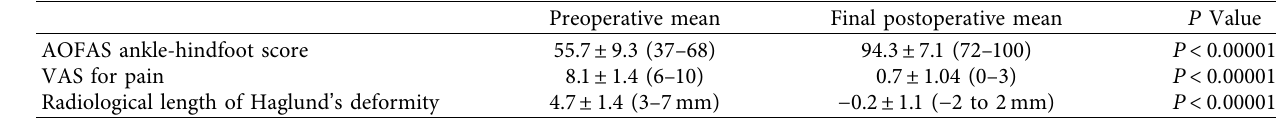
Figure 6: Adequate endoscopic resection of the bone with no prominence above the parallel pitch line (red line) at the 4-year postoperative follow-up. Table 2: Final results of functional scores and radiological